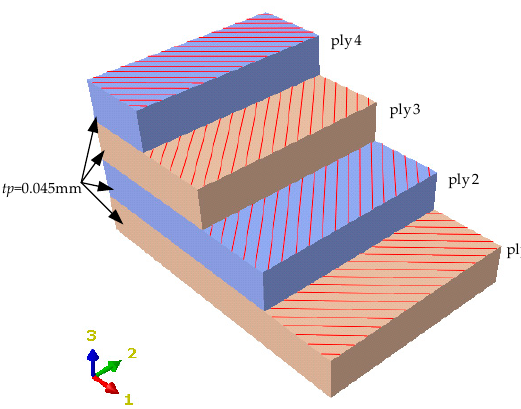
Figure 4. Ply angle diagram of the FLHD boom. Table 1. Material properties of T800.